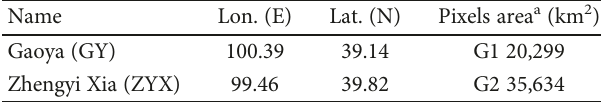
Figure 3: Evapotranspiration and stream fl ow from the GLDAS four land surface models; (a) and (c) represent monthly scales, respectively, and (b) and (d) represent mean seasonal cycles, respectively. Table 2: Information of the hydrological